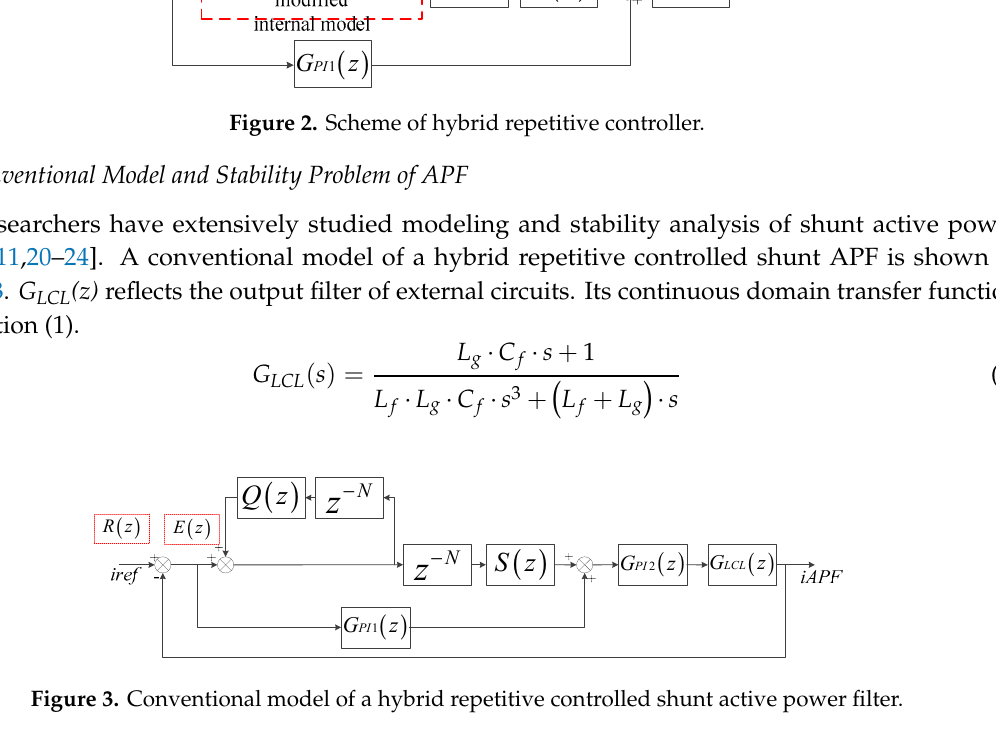
Figure 3. Conventional model of a hybrid repetitive controlled shunt active power filter.